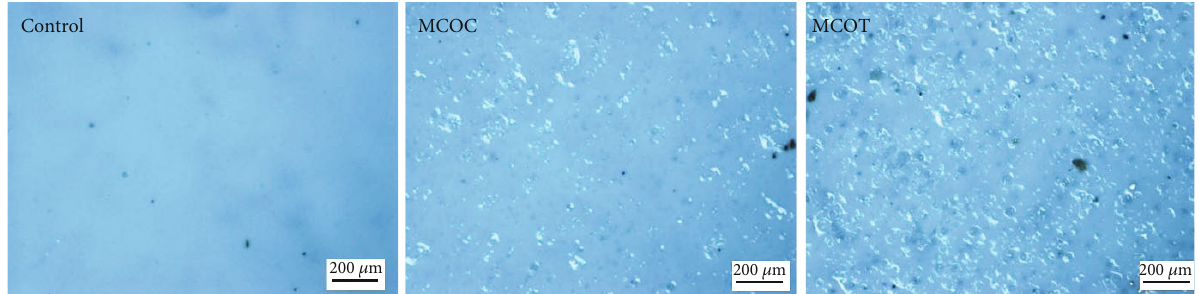
Figure 10: Optical microscopy images of the surfaces of the control, MCOC, and MCOT